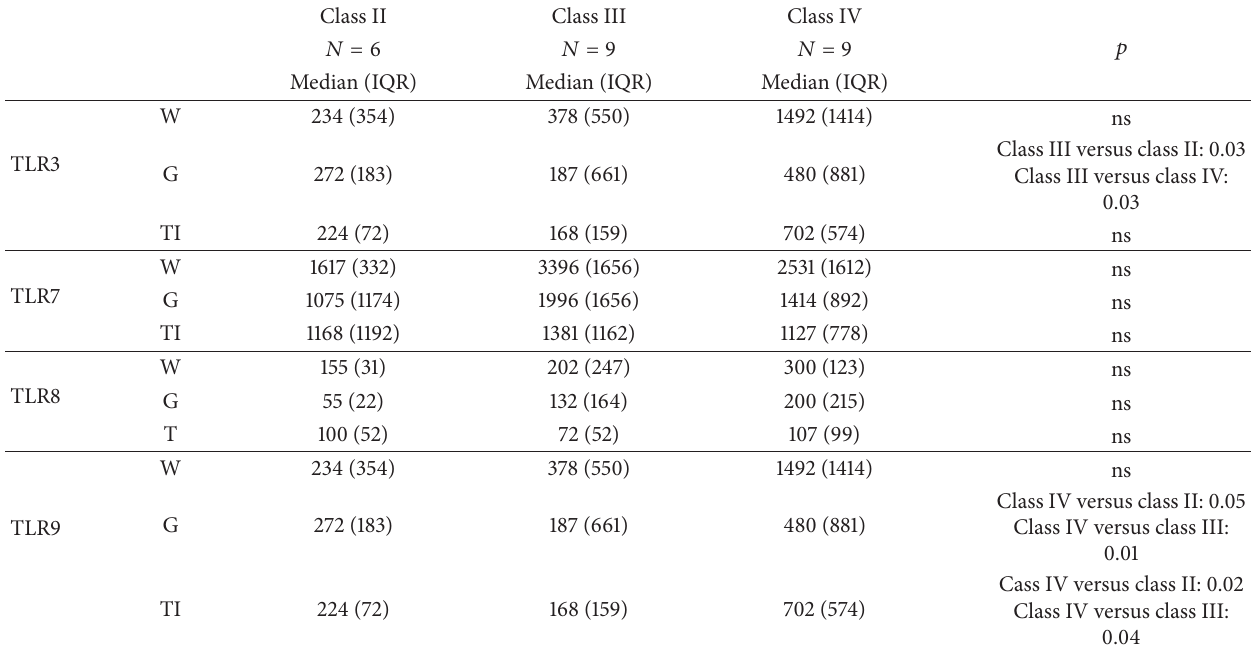
Table 3: Number of positive cells/mm 2 expressing each TLR at glomerular level and at tubulointerstitial level or at both in class II, class III, and class IV lupus nephritis